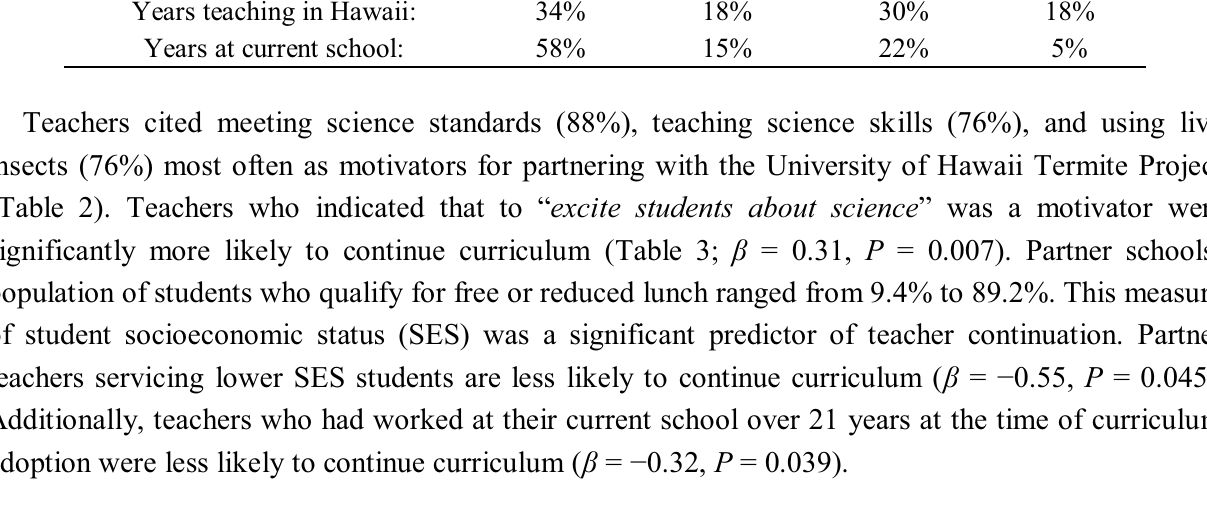
Table 2. Educate to Eradicate partner teacher motivations for adopting curriculum.